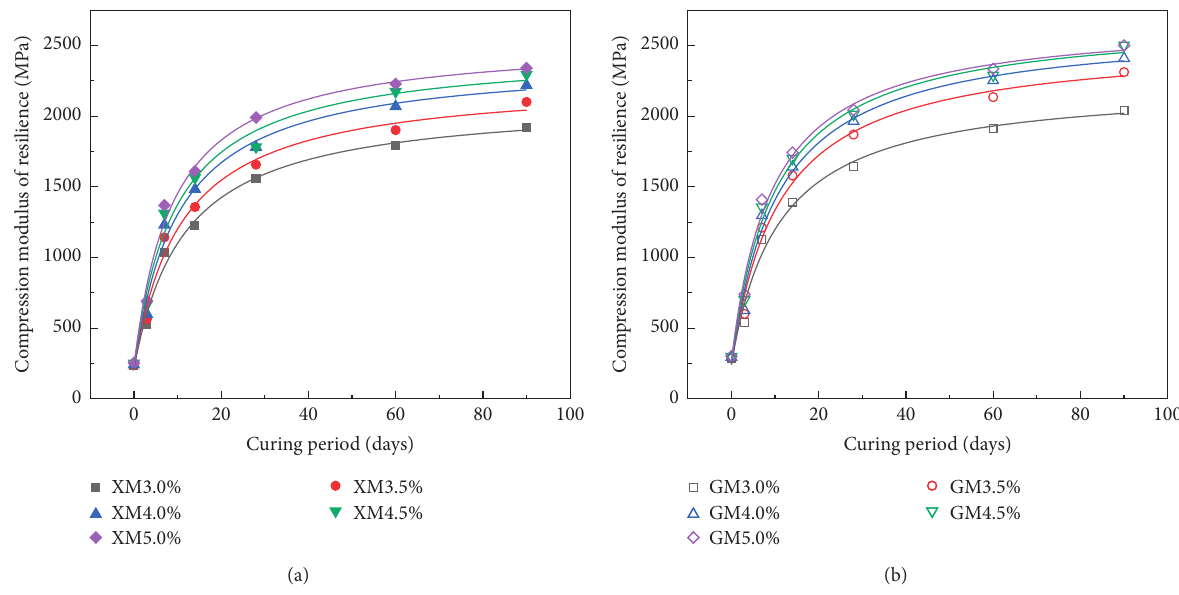
Figure 9: Effect of curing period on compression modulus of resilience. (a) GM gradation; (b) XM